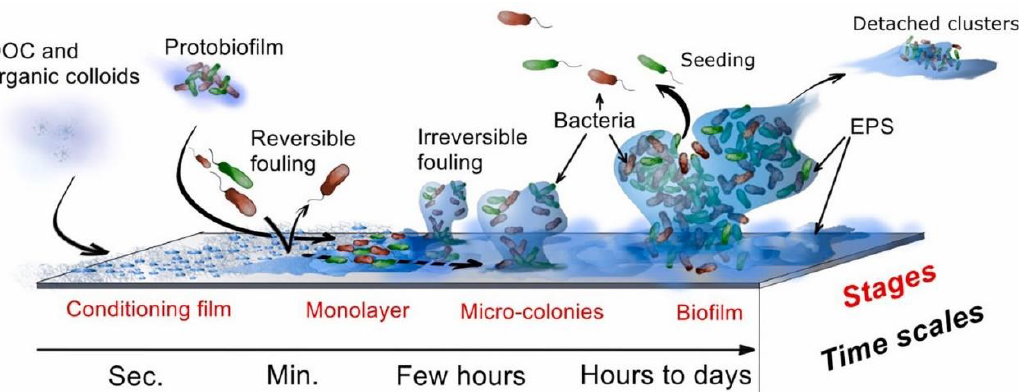
Figure 2. The sequence of stages leading to the formation of biofilm [33 – 35]. (Copyright (2015) with permission from American Chemical Society), (Copyright (2020) with permission from American Chemical Society), (Copyright (2014) with permission from Elsevier Ltd.).